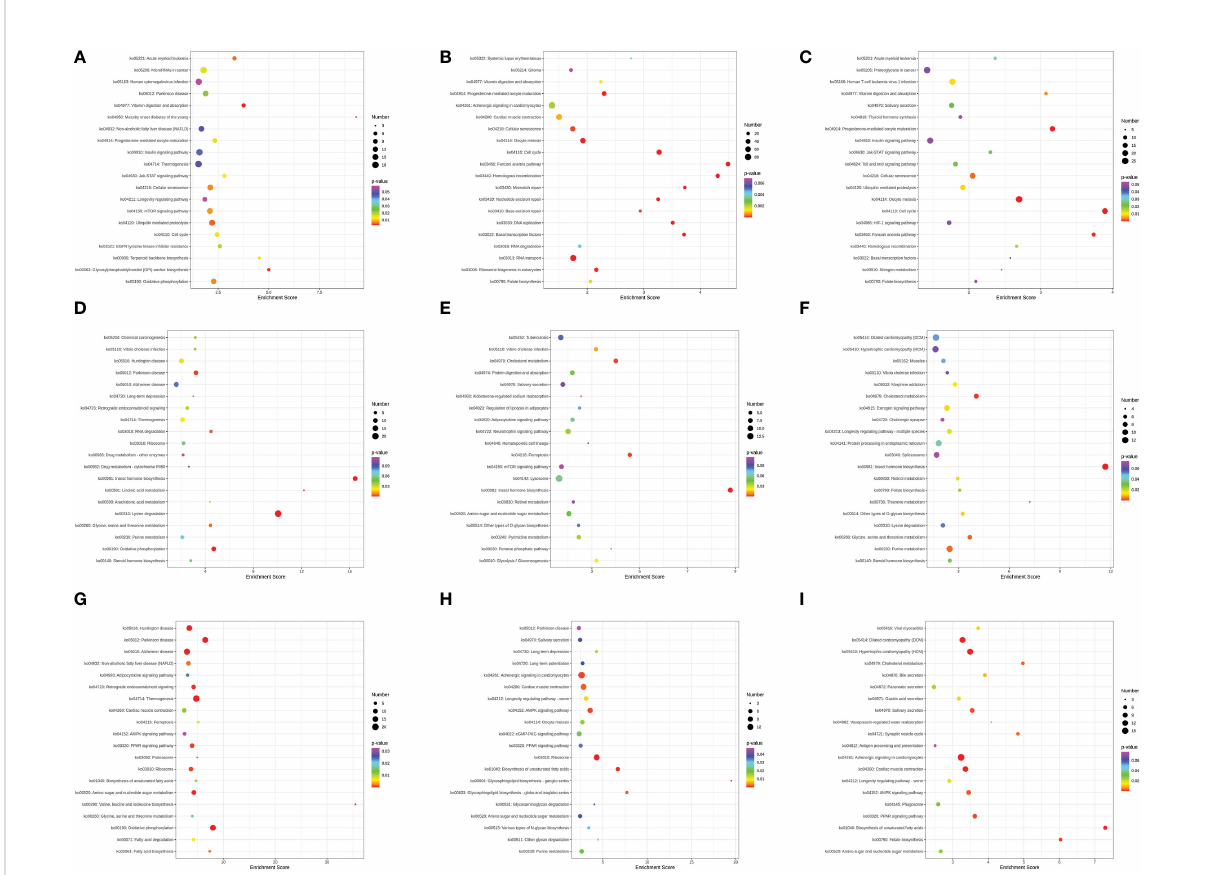
FIGURE 9 Results of Top 20 KEGG pathways enrichment in the gills (A – C) , hepatopancreas (D – F) , and muscle (G – I) of M. nipponense exposed to different salinity gradients,